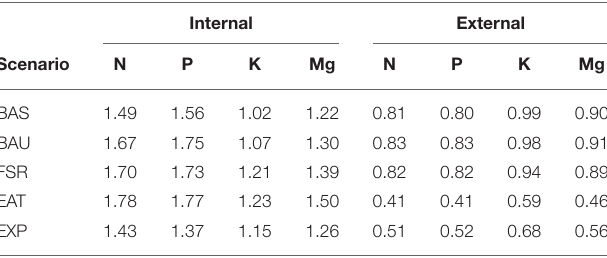
TABLE 5 | Nutrient self-reliance—long-term potential. Internal External Scenario